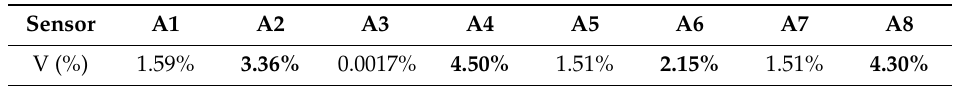
Table 19. The measured concentration volume fraction of deployment scheme based on PSO algorithm. Table 20. The measured concentration volume fraction of deployment scheme based on DE algorithm.